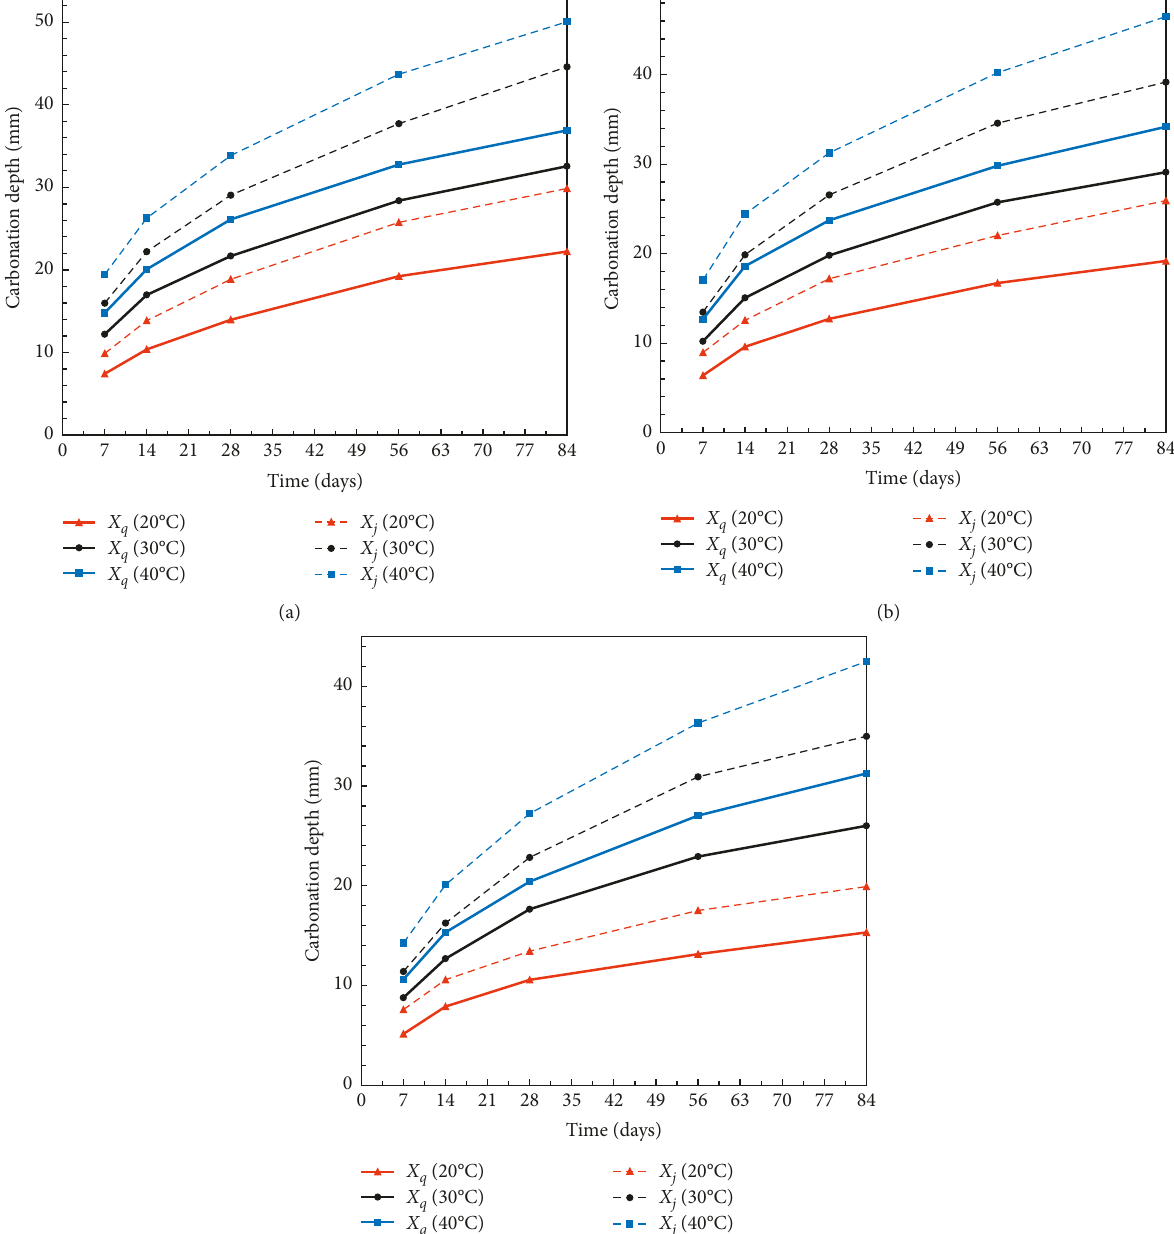
0.65); (b) C30 concrete ( w/c (cid:31)